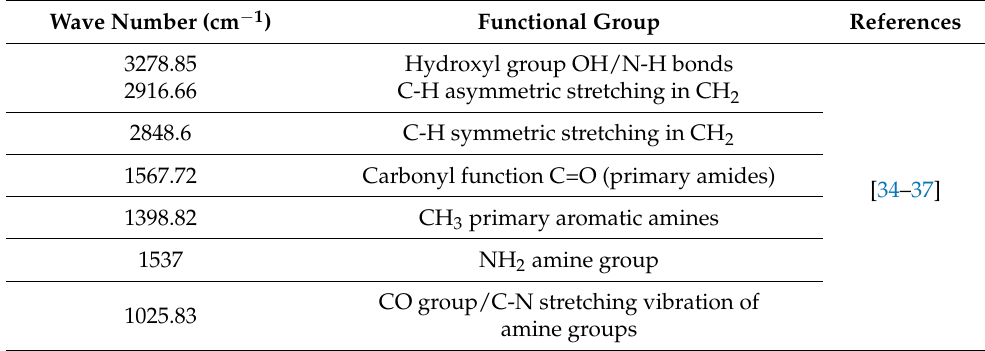
Table 1. Active functional groups in the four bio-coagulants.